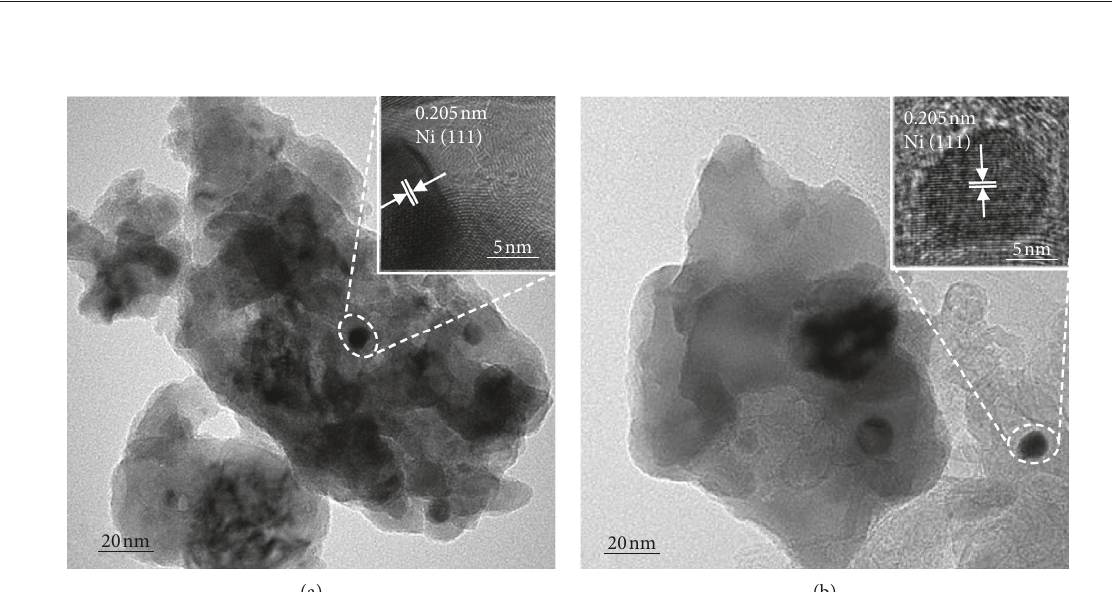
Figure 7: The TEM images of LaFe 0.5 Ni 0.5 O 3 (a) after the reduction and (b) after stability test.